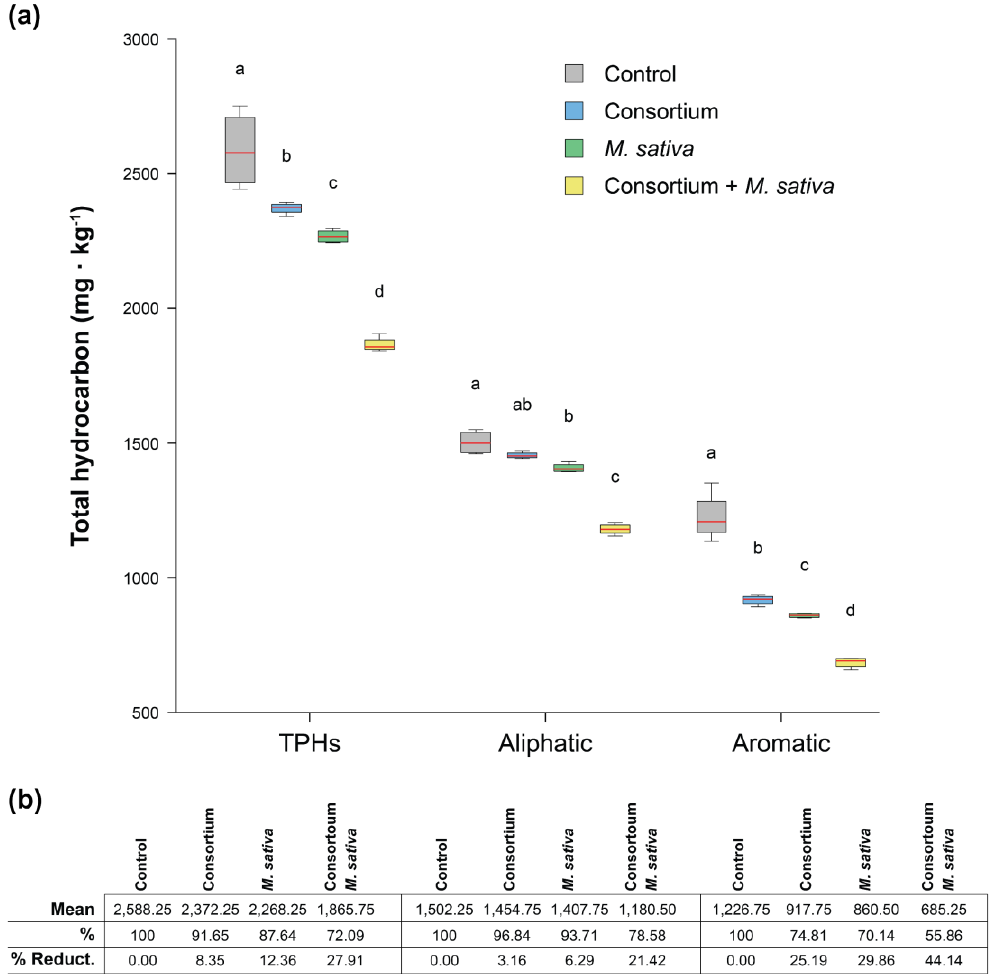
Figure 5. ( a ) Gas chromatography with a flame ionized detector (GC-FID) results of total hydrocarbons remaining after four-month treatments with the diesel-degrading consortium, alfalfa ( M. sativa ) plants without inoculum, and combined consortium and alfalfa plants in four-month microcosms assays. Each box indicates Q1 and Q3, while the red line indicates the median values out of four replicates. Error bars indicate maximum and minimum values. Di ff erent letters indicate statistically significant di ff erences ( p < 0.05) using two-way ANOVA with Tukey’s multiple comparison test corrections. ( b ) Mean values in each treatment in mg · kg − 1 out of four replicates and percentages compared to the control.